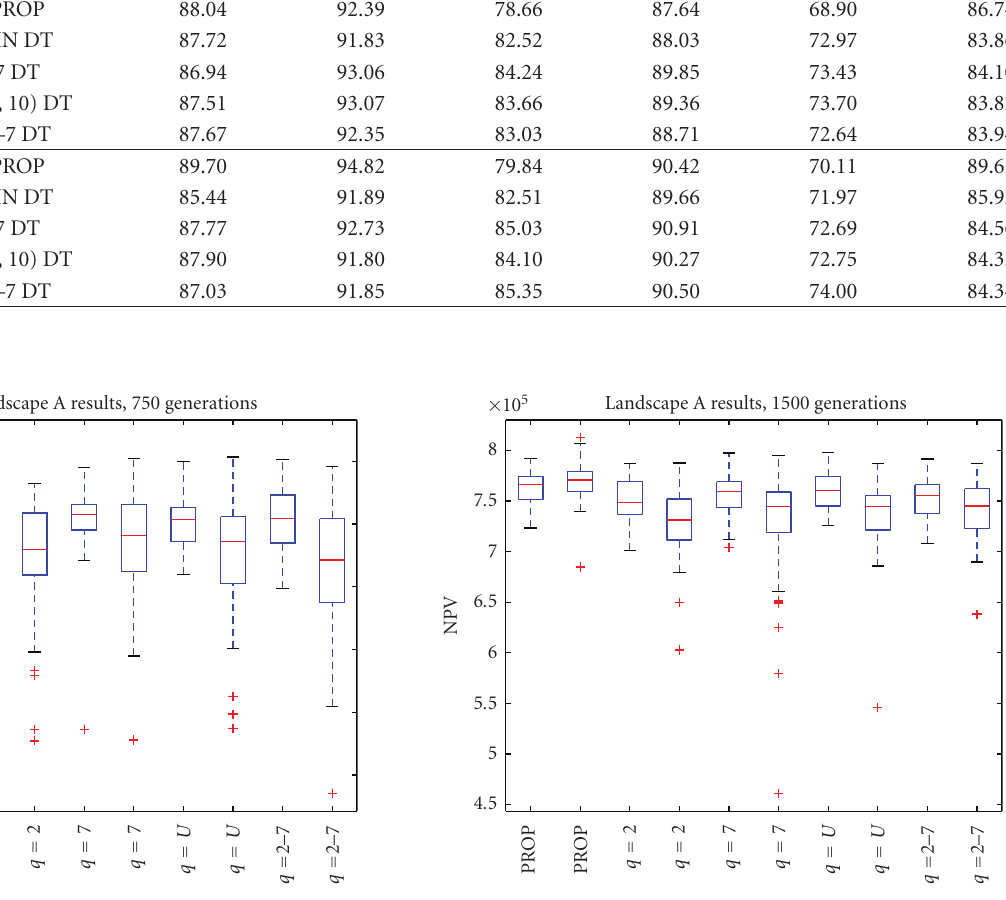
Figure 2: Results for Landscape A, 1500 generations. This figure presents a box-plot of solution quality (NPV; y -axis) for each paired selection/penalty strategy tested. The x -axis displays the strategy; static and dynamic penalty strategies for the same selection strategy are displayed side by side (static on the left side). Reading from left to right, the first selection strategy presented is proportional selection and the rest are deterministic tournaments with various competitor pool sizes ( q ). The label “ q = U ” corresponds to the strategy wherein q was sampled from a uniform distribution over the range (2, 10), and the label “ q = 2–7” corresponds to the strategy where q increased from 2 to 7 during the